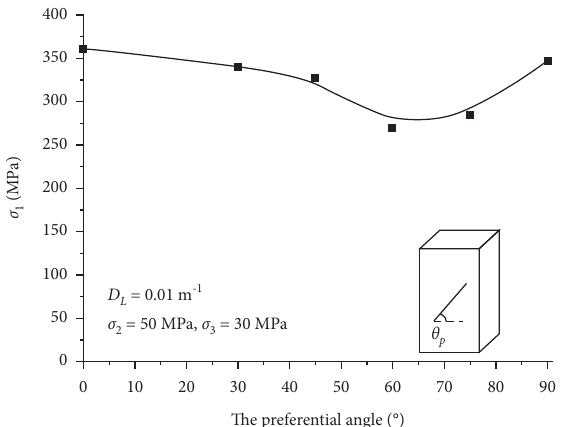
Figure 9: Effect of preferential angle on the strength of specimens containing single